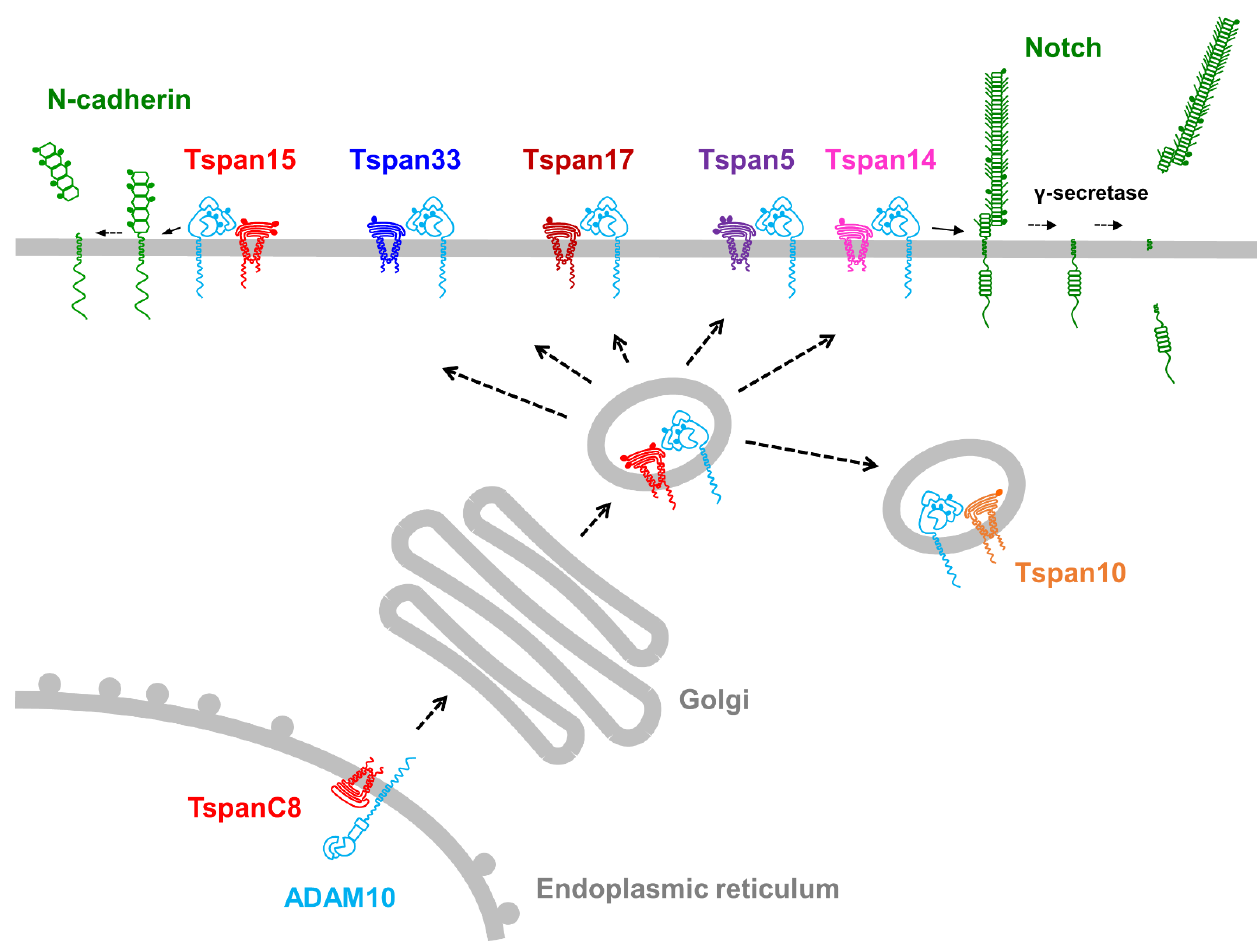
Figure 2. Regulation of ADAM10 by TspanC8 tetraspanins. ADAM10 interaction with one of six TspanC8 tetraspanins is required for its exit from the endoplasmic reticulum, trafficking to the cell surface or intracellular vesicles, and cleavage of distinct substrates. Definitive examples of the latter are cleavage of N-cadherin by Tspan15/ADAM10 complexes and cleavage of Notch by Tspan5/ADAM10 and Tspan14/ADAM10 complexes. Filled circles on membrane protein ectodomains represent N-linked glycosylation and angled lines represent O-linked glycosylation.